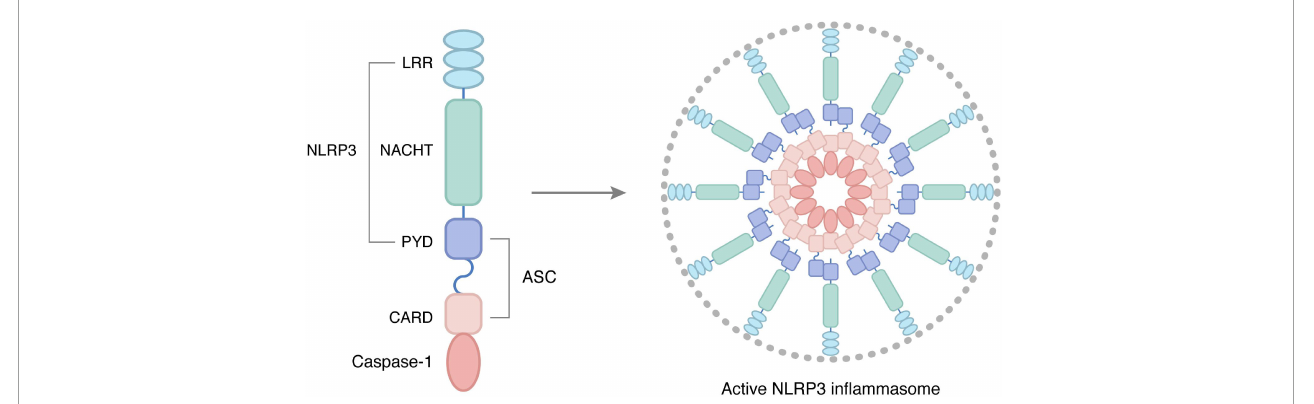
FIGURE2 Structure and activation of NLRP3 inflammasome, as core proteins in the NLRs family, are important members of the body’s intrinsic immune system, and their abnormal activation is closely related to various chronic inflammatory conditions. NLRP3 inflammasome consists of three parts: receptor, adapter, and effector, namely NOD-like receptor protein 3, junction molecule apoptosis-associated protein ASC, and cysteine aspartate protease. In particular, the receptor NLRP3 is articulated by three homologous structural domains: the C-terminal leucine-rich repeat (LRR), the central nucleoside triphosphatase domain (NACTH), and the N-terminal pyrindomain (PYD). In the resting state, NLRP3 expression in cells is at very low levels, and upon binding to signals mediating NLRP3 inflammasome initiation, activates NLRP3 inflammasome thereby participating in the inflammatory